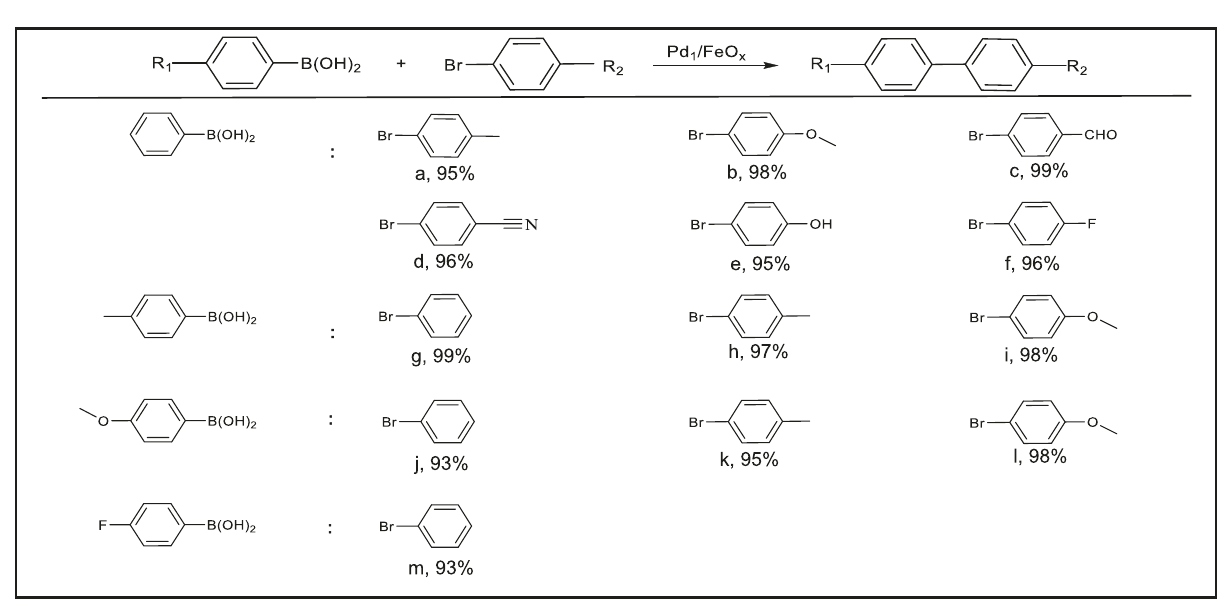
Fig. 6 | Suzuki – Miyaura cross-coupling of aryl bromide and aryl boronic acids catalyzed by Pd 1 /FeO x -1. Reaction conditions: 10mg catalyst, aryl bromide